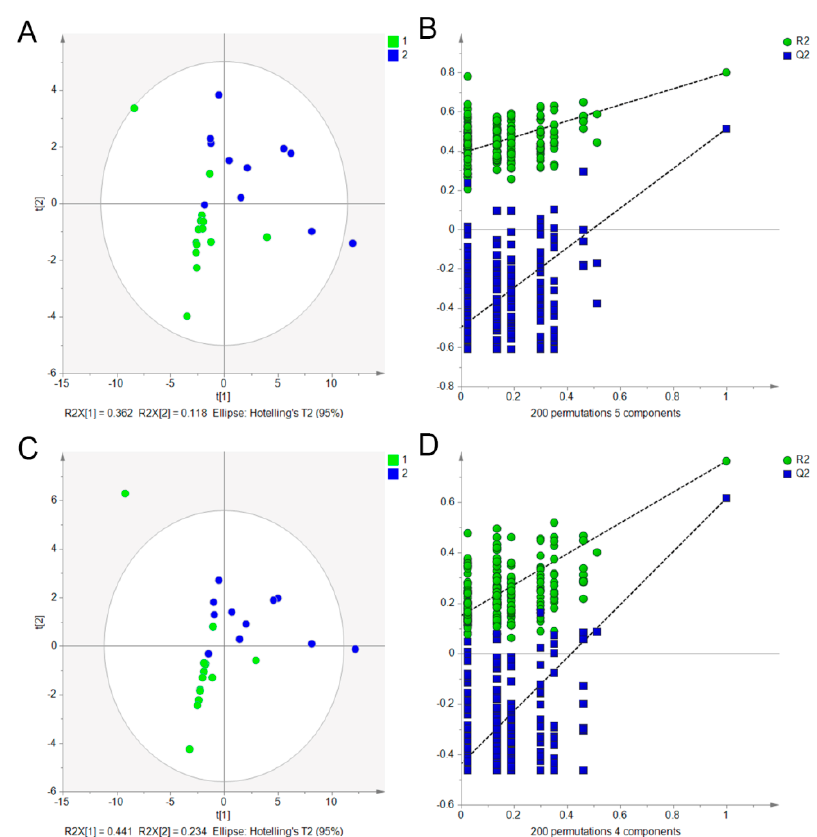
Figure 3. PLS–DA model for NRRs planted in the Sichuan province and others, depending on 19 compounds ( A ) with their corresponding permutation plots ( B ) and 6 markers ( C ) with the corresponding permutation plots ( D ).